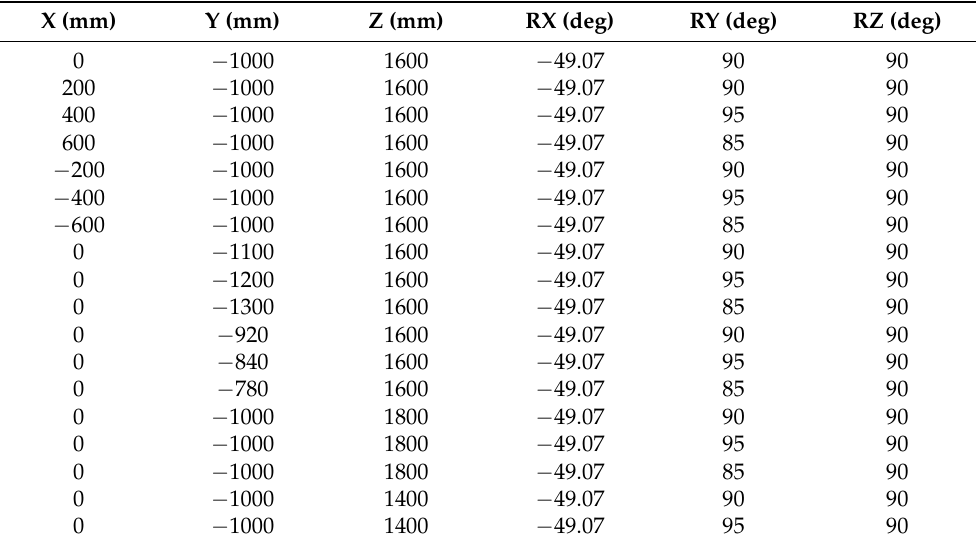
Table 1. Set of positions (in robot reference frame) to form the